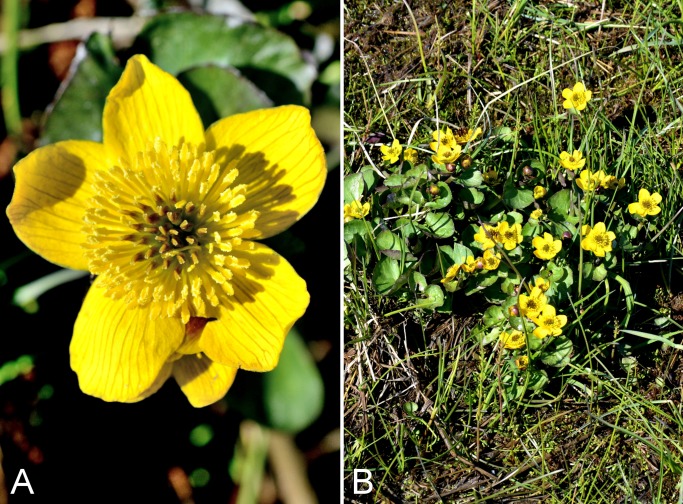
Caltha palustris subsp. radicans.(A) Inflorescence, Saarela et al. 3104. (B) Habit, Saarela et al. 3104. Photographs by P. C. Sokoloff.